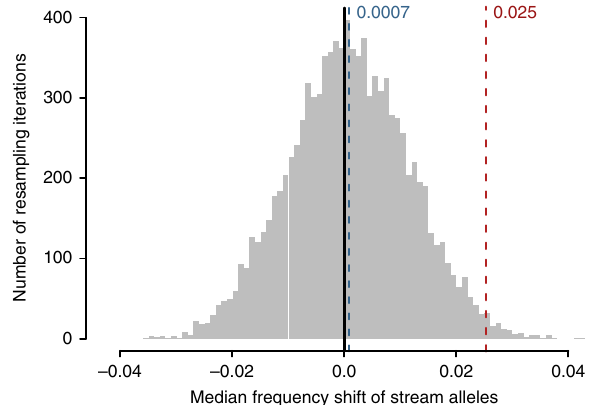
Fig. 4 Observed allele frequency shift at the target SNPs compared to neutral SNPs. Distribution of the median reference-survivors frequency shift of the stream allele across 126 neutral SNPs, based on 9999 replicate resampling iterations. The neutral SNPs were required to lie within an AFD range of 0 – 0.1 in the comparison of the lake and stream population, and were further constrained to a minor allele frequency (MAF) spectrum matching the one observed across the target SNPs by applying a MAF threshold of 0.35 in the reference sample. The dashed blue line indicates the grand median random shift. The dashed red line gives the median reference-survivors shift of the stream allele observed across the 126 target SNPs during the fi eld